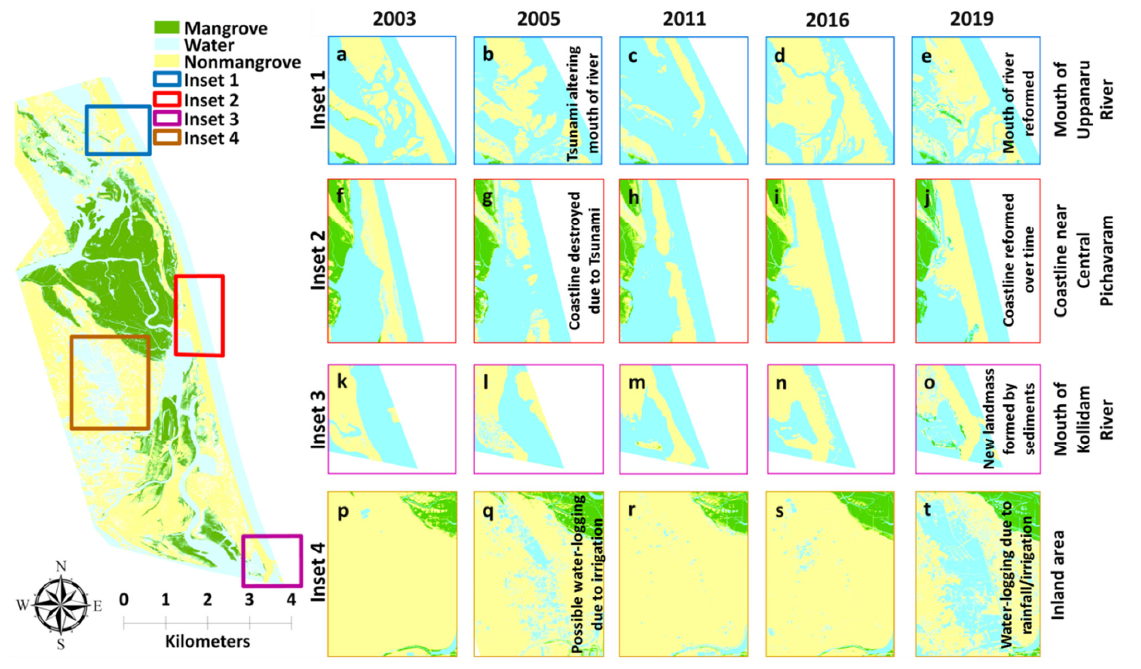
Figure 7. Changes, with a focus on the land (mangrove or non-mangrove) to water changes, in the land-cover of Pichavaram area and surrounding areas such as ( a – e ) the mouth of the Uppanaru River, ( f – j ) coastline near the central Pichavaram forest, ( k – o ) the mouth of the Kollidam River, and ( p – t ) inland area.